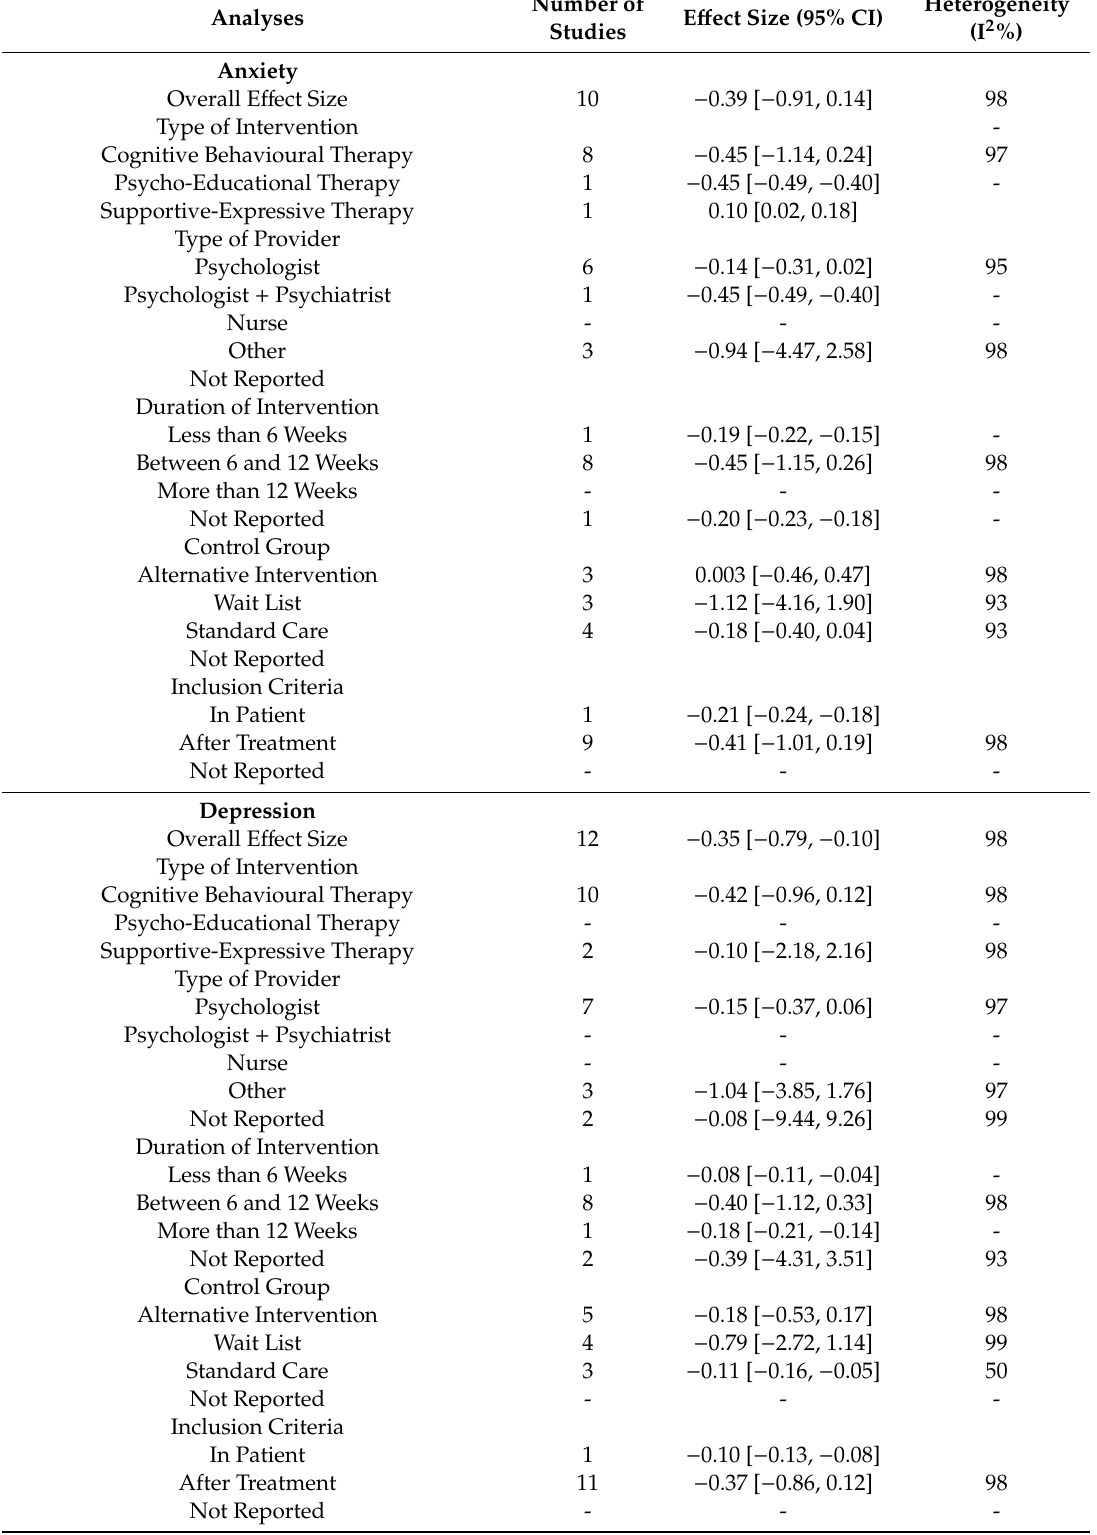
Table 3. E ff ect size (Cohen’s d) for each